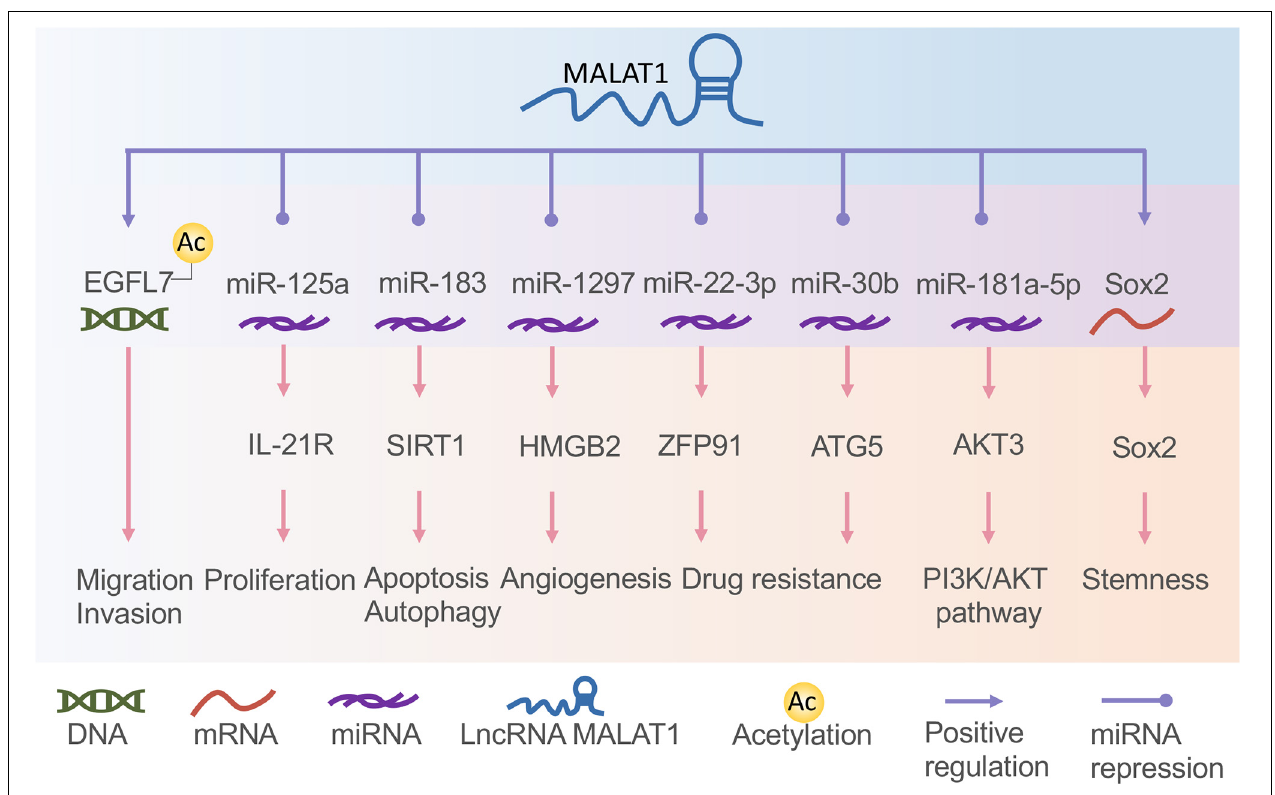
FIGURE 2 | The functions of long non-coding RNA (lncRNA) metastasis-related lung adenocarcinoma transcript 1 (MALAT1) in gastric cancer and nasopharyngeal carcinoma. MALAT1 interacts with DNA, messenger RNA (mRNA), and microRNA (miRNA) to regulate tumor cell proliferation, migration, invasion, angiogenesis, drug resistance, apoptosis, and